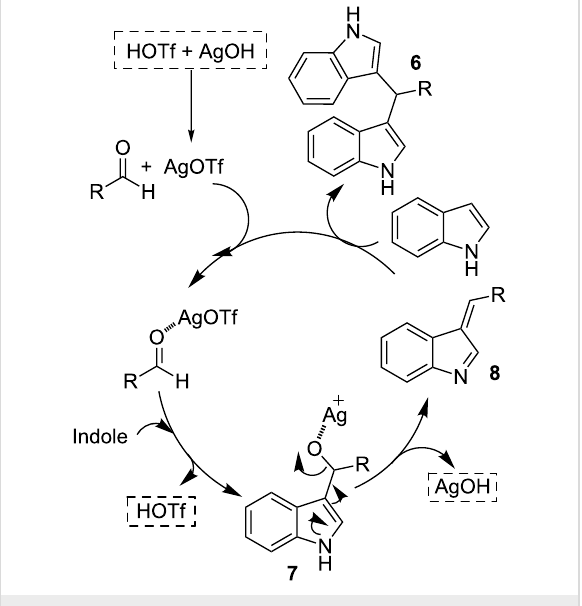
Scheme 3: Mechanism of the synthesis of bisindoles through AgOTf